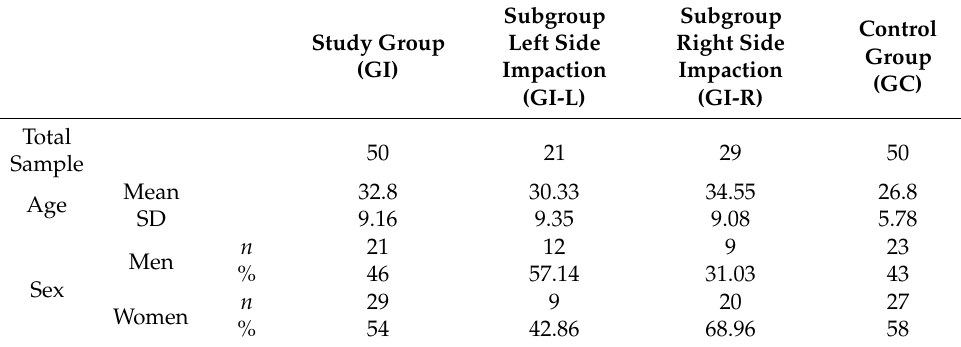
Table 1. Demographic characteristics of participants ( n =